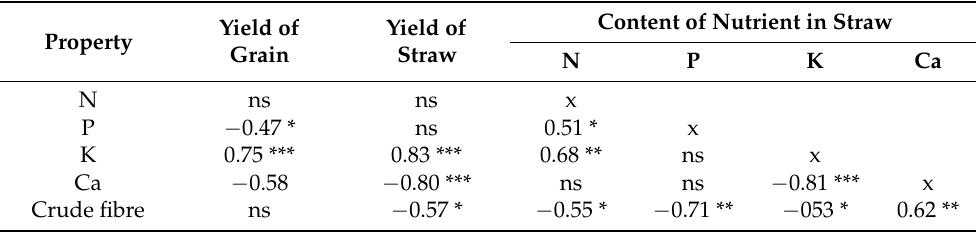
Table 12. Simple correlation coefficients between yield and nutrient content in straw of spring barley in experimental period (2009 to 2011) ( n =